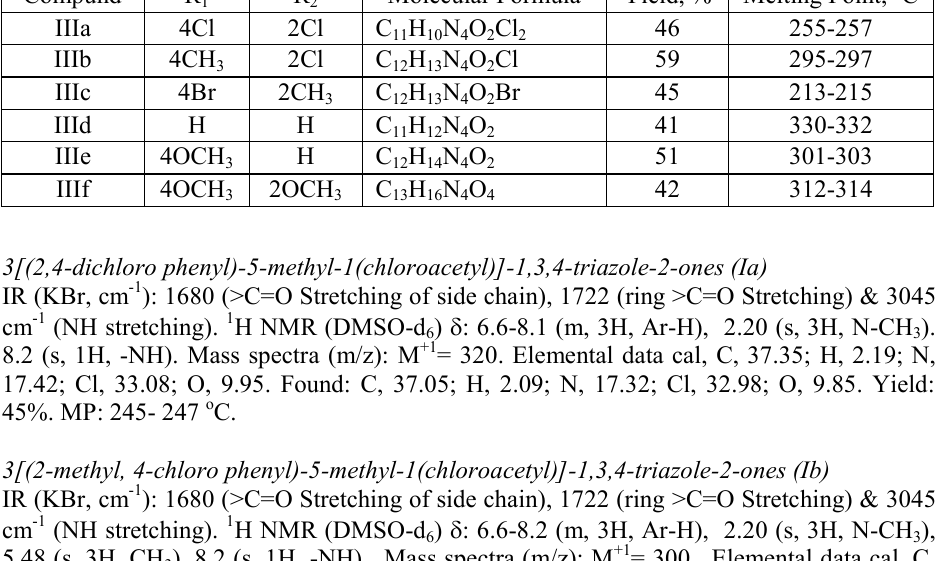
Table 3. Physical and analytical data of compound III and its other substituted derivatives.